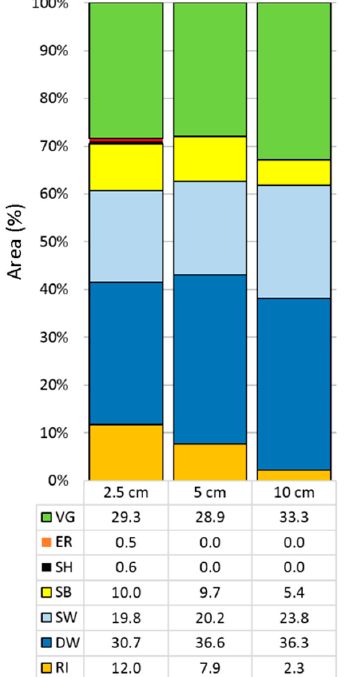
Figure 5. Area falling under each feature class for each of the resolutions considered. The number of pixels per resolution was 67,446,624, 17,301,453 and 5,706,057 for 2.5 cm, 5 cm and 10 cm, respectively. The codes used for each of the features are as follows: side bar (SB), erosion (ER), riffle (RI), deep water (DW), shallow water (SW), shadow (SH) and vegetation (VG).